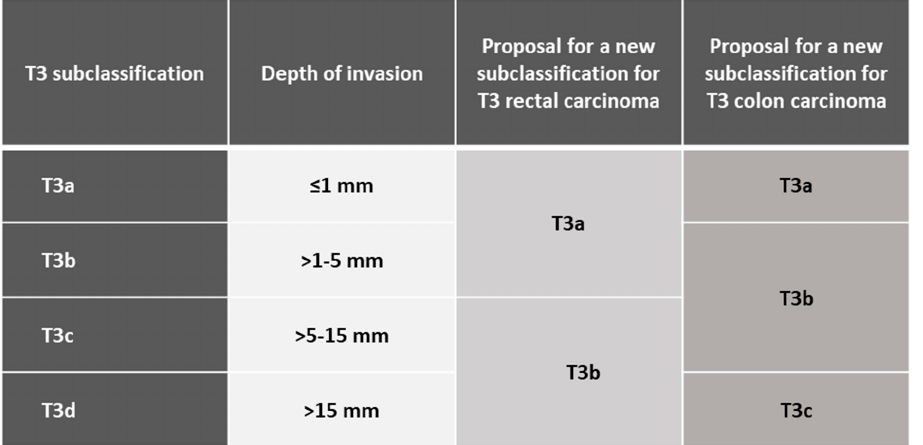
Figure 3. Proposal for a new subclassification for T3 rectal and colon carcinoma.